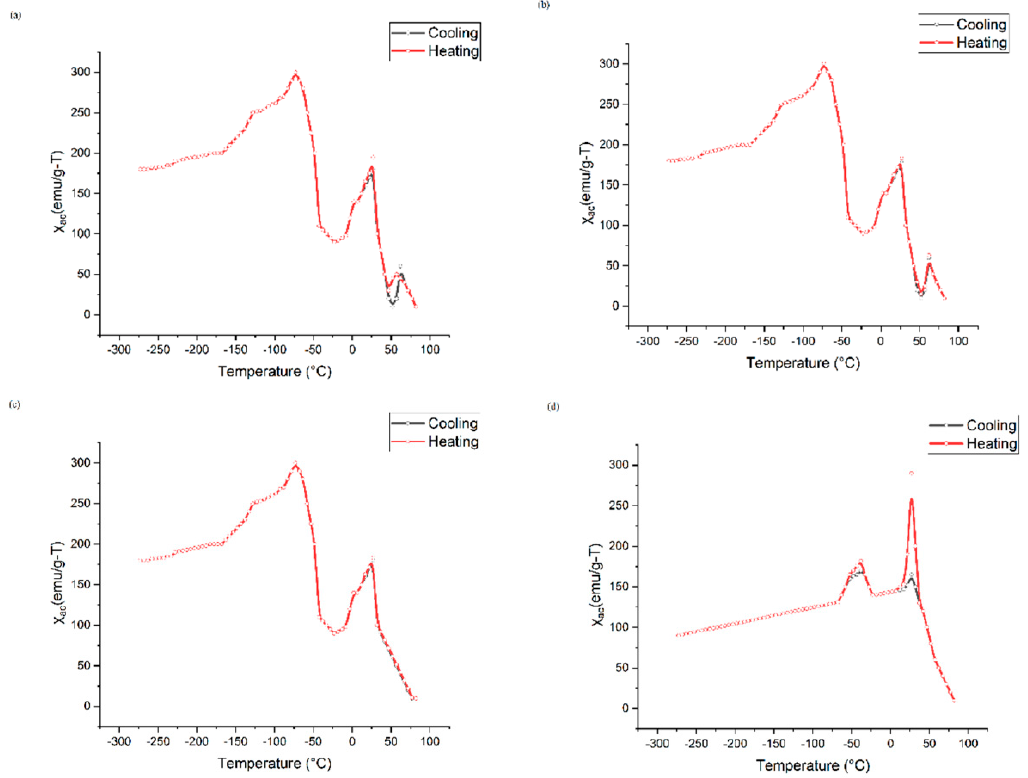
Figure 6. AC susceptibility vs. temperature curves for Ni 50 − x Fe x Mn 30 Sn 20 − y In y 1 ≤ x ≤ 4; 2 ≤ y ≤ 8 alloy, where ( a ) x = 1; ( b ) x = 2; ( c ) x = 3; ( d ) x = 4.